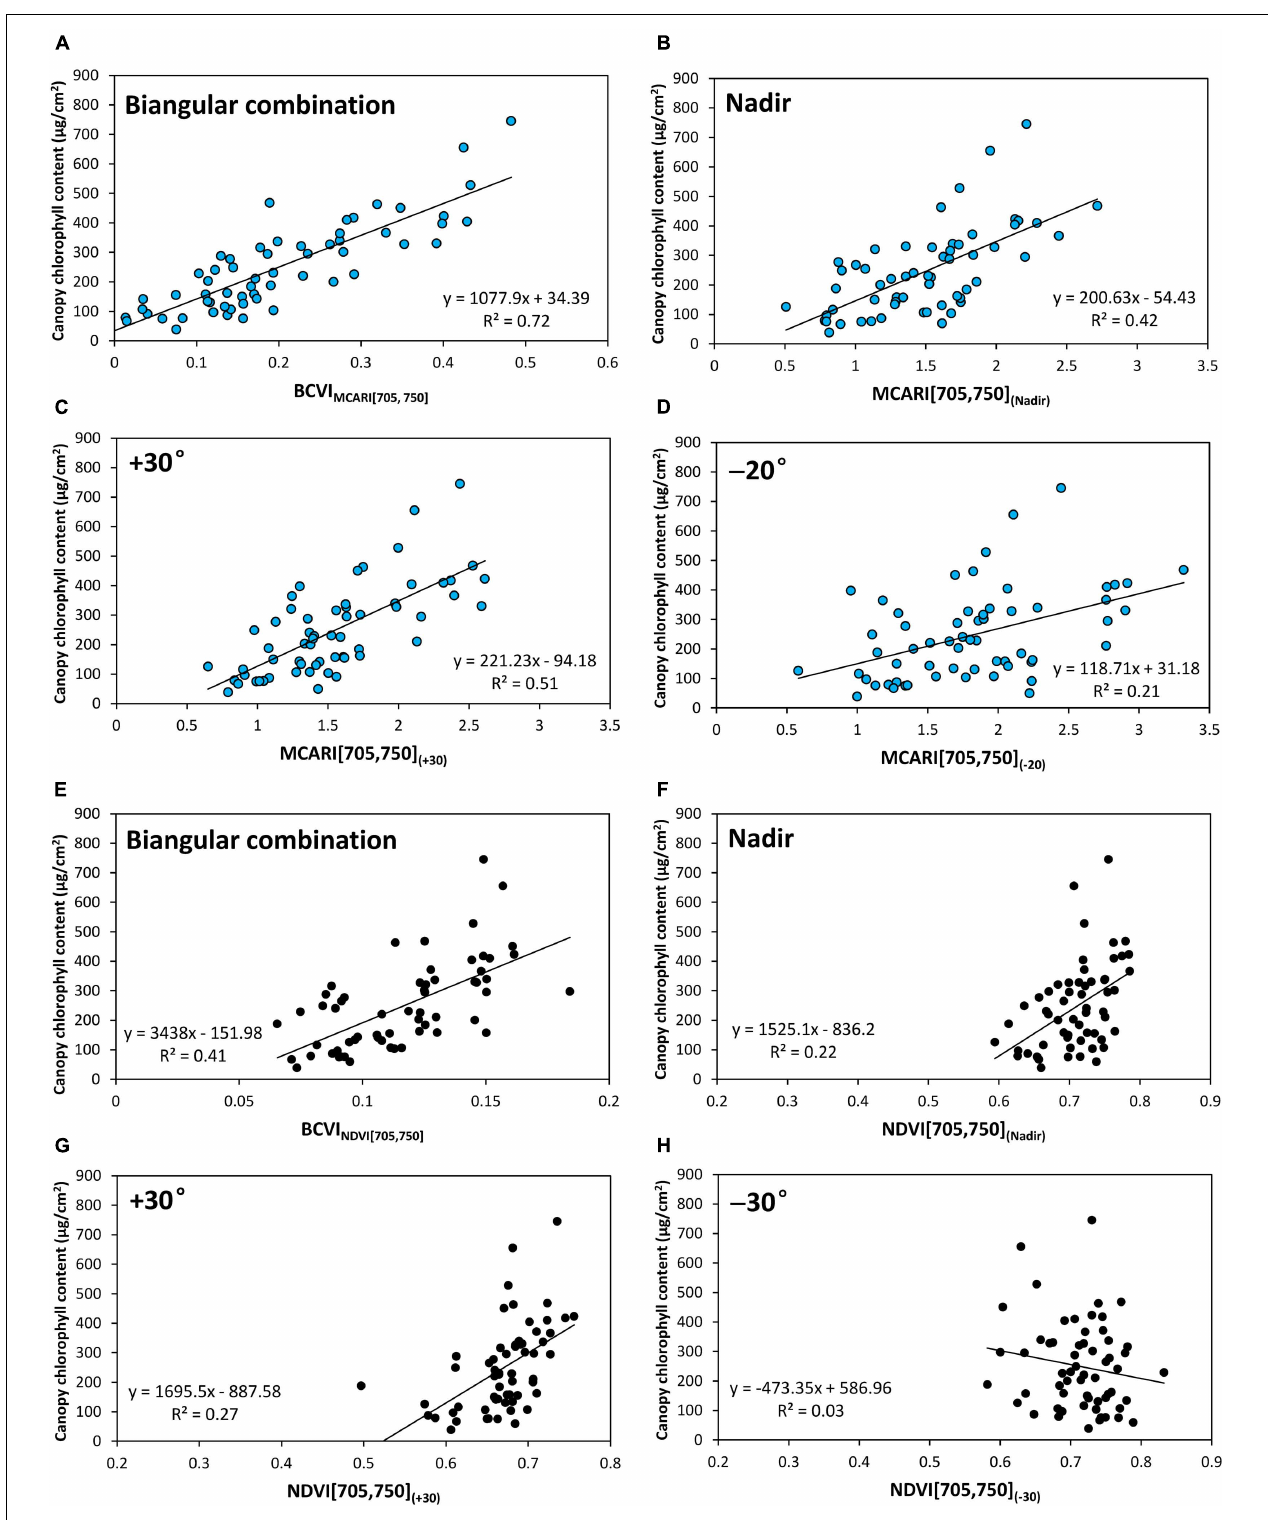
FIGURE 10 | Scatterplots of relationships between canopy chlorophyll content and BCVIs and the corresponding mono-angular VIs based on MCARI[705,750] and normalized difference vegetation index (NDVI)[705,750] for filed experimental datasets. The blue points (A–D) represent the BCVI NDVI [ 705 , 750 ] , MCARI[705,750] ( Nadir ) , MCARI[705,750] ( + 30 ) , and MCARI[705,750] ( − 20 ) , respectively; the black points (E–H) represent the BCVI NDVI [ 705 , 750 ] , NDVI[705,750] ( Nadir ) , NDVI[705,750] ( + 30 ) , and NDVI[705,750] ( − 30 ) , respectively.